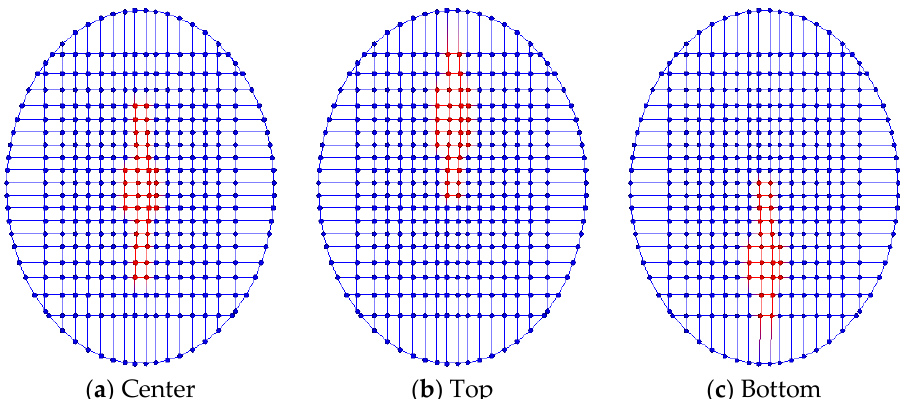
Figure 12. Simulated results of sliding intersections of tennis racket (intersections that slid ware shown as red circles, non-sliding intersections are shown as blue circles).